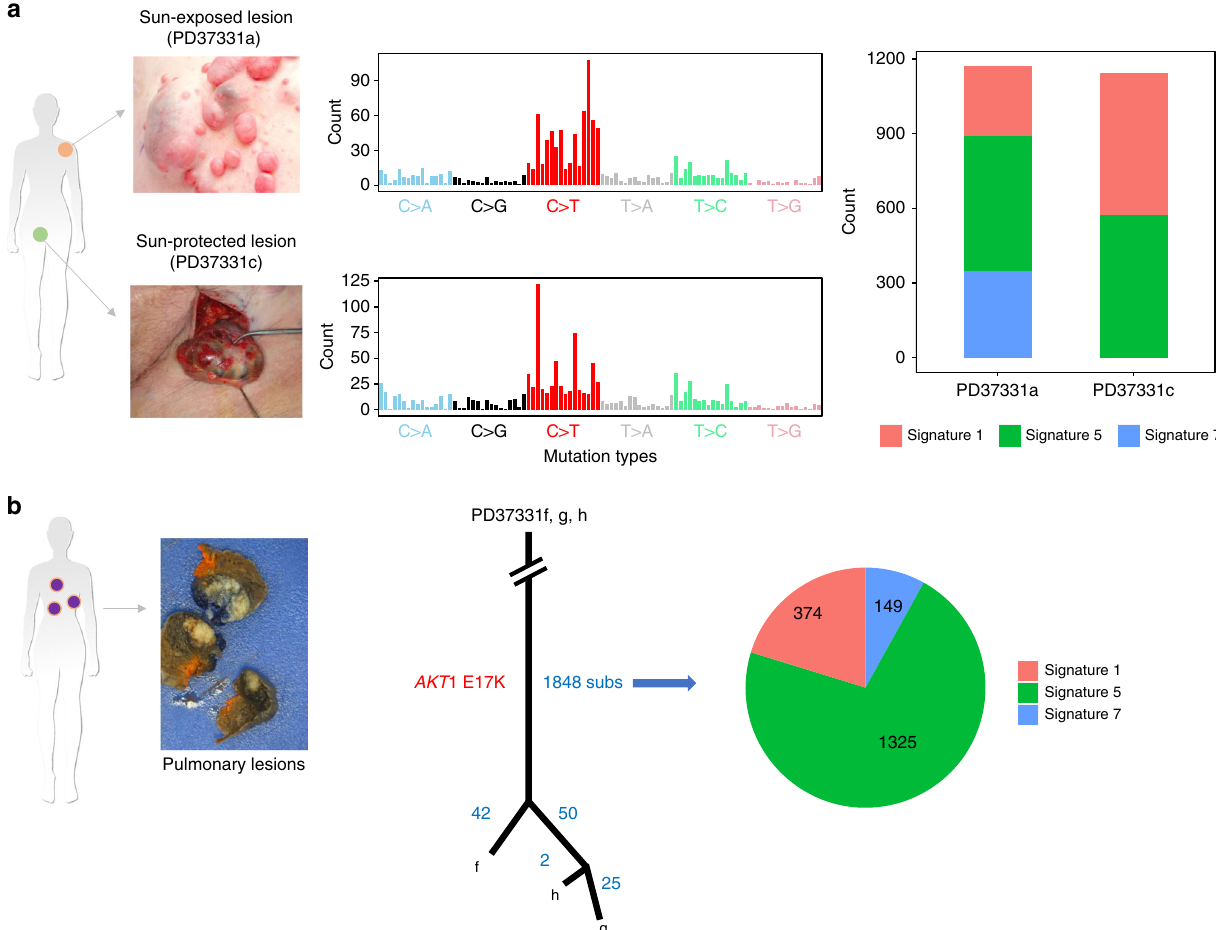
Fig. 4 UV signature analysis reveals distinct mutational mechanisms in skin and tracks origin of lung tumors. a Examples of intermittently sun-exposed and sun-protected CCS tumors demonstrate differing mutational pro fi les. Mutational signature analysis reveals UV-related signature 7 in sun-exposed tumors only. b In one patient with three pulmonary lesions, a phylogenetic analysis reveals 1848 mutations were shared in common and showed a UV signature. Hence, these benign pulmonary lesions had a common origin, likely sun-exposed conjugated goat-anti-mouse) were applied the following day and visualized with a fl uorescent microscope (Zeiss Axioimager Z2, with Apotome 2 — Carl Zeiss, UK). Whole-genome sequencing and whole-exome sequencing . DNA was extracted from 12 cases along with corresponding normal tissue and subjected to paired-end WGS on an Illumina HiSeq X Ten 33,36 . DNA for WES was extracted from blood and cyrosections of snap frozen tissue, and in fi ve cases from formalin- fi xed par- af fi n-embedded tissue (PD37330h, PD40536c, PD40540a, PD40545a, and PD40545c). Forty-two WES library samples were prepared using the Illumina Nextera DNA Exome Kit, prior to being sequenced on a S2 fl owcell on an Illumina Novaseq machine. Three WES samples were enriched using the SureSelect Human All ExonV6 + UTR and 100 base paired-end sequencing performed on an Illumina Hiseq 2500 genome analyzers. For WES sequence depth was on average 255 - fold. Resulting BAM fi les were aligned to the reference human genome (GRCh37) using Burrows-Wheeler Aligner, BWA-0.7.16a (r1181). Mutation calling was performed using CaVEMan (Cancer Variants through Expectation Maximization: http:// cancerit.github.io/CaVEMan/) for calling somatic substitutions 33 . Indels in the tumor and normal genomes were called using a modi fi ed Pindel version 2.0 (http:// cancerit.github.io/cgpPindel/) on the NCBI37 genome build. Structural variants were discovered using a bespoke algorithm, BRASS (BReakpoint AnalySiS; https:// github.com/cancerit/BRASS) through discordantly mapping paired-end reads fol- lowed by de novo local assembly using Velvet to determine exact coordinates and features of breakpoint junction sequence. All mutations were annotated according to ENSEMBL version 75. ASCAT copy number analysis . Allele-speci fi c copy number analysis of tumors analyzed by WGS was performed using ASCAT (v2.1.1) 33 . ASCAT takes non- neoplastic cellular in fi ltration and overall tumor ploidy into consideration, to